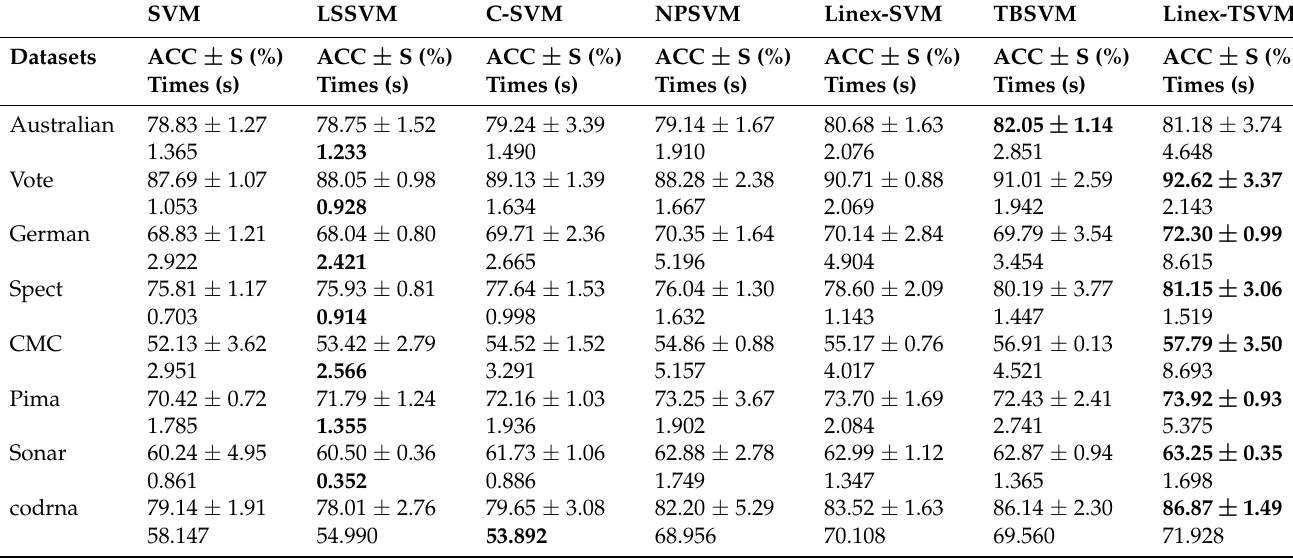
Table 4. Experimental results on UCI datasets with 25% Gaussian